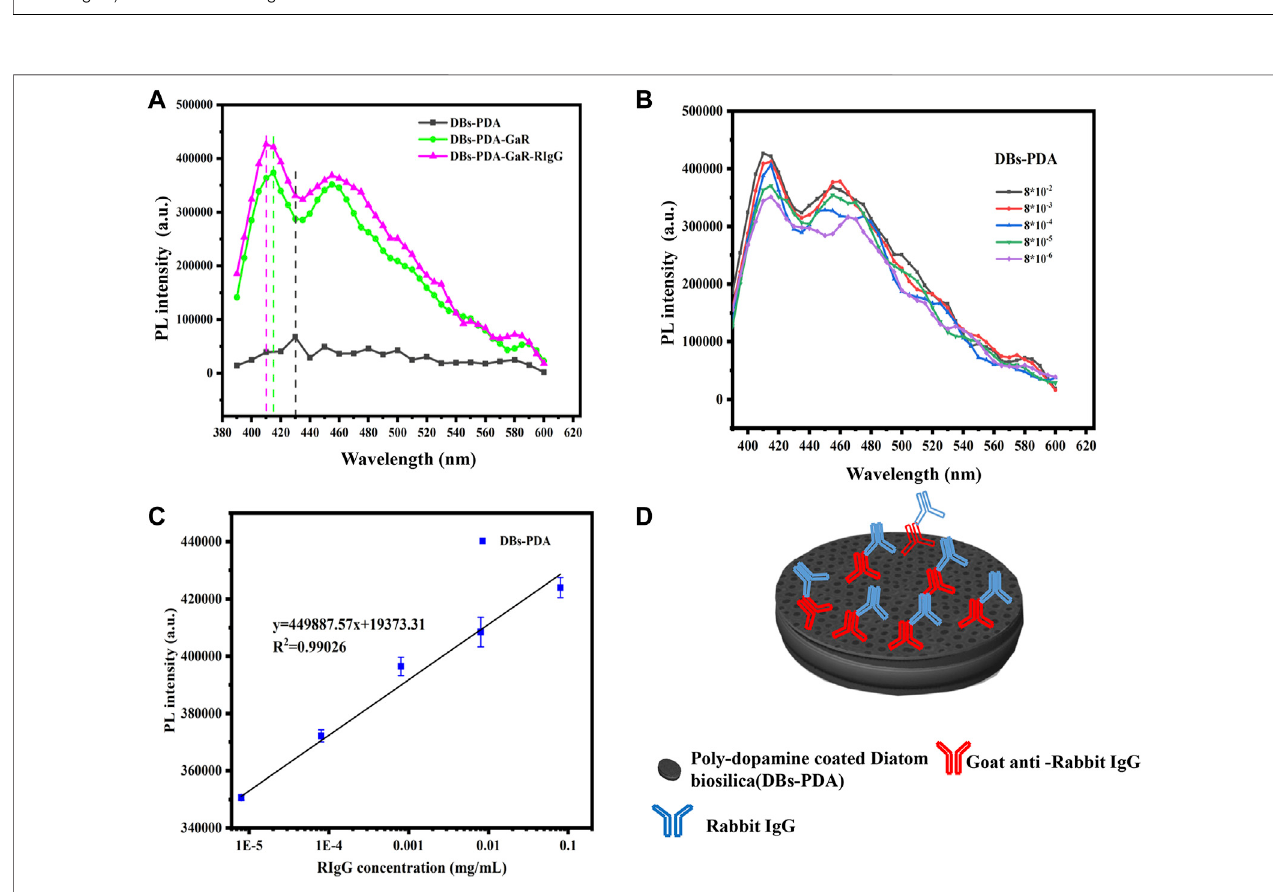
FIGURE 8 | (A) PL spectra of DBs-PDA, DBs-PDA-GaR, and DBs-PDA-GaR against its complimentary antigen (RIgG). (B) PL spectra showed DBs-PDA-GaR versusdifferentconcentrationsofRIgG(from8×10 − 6 to8×10 − 2 mg/ml). (C) PLintensityofDBs-PDA-GaR labeled withdifferentconcentrationsofRIgG(from8×10 − 9 to 8 × 10 − 2 mg/ml) with a coef fi cient of determination ( R 2 ) of 0.97815. Excitation wavelength was 360 nm. (D) Schema of RIgG binding with